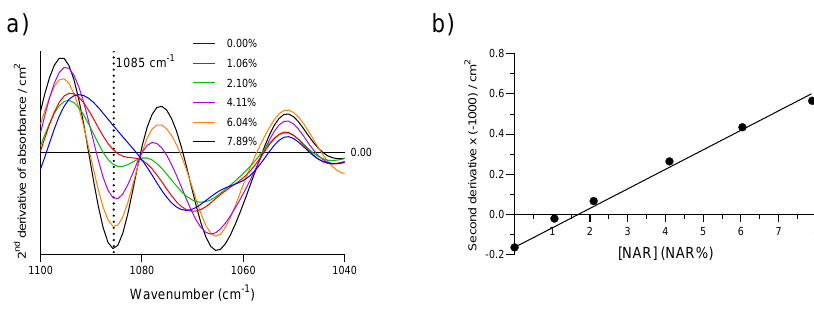
Figure 5. ( a ) The second derivative of the absorbance spectra of SFN with increasing quantities of NAR obtained at Stockholm University; ( b ) Calibration line constructed with the second derivative of the Absorbance spectra at 1085 cm − 1 multiplied by − 1. Each spectrum was smoothed with a thirteen-point Savitsky–Golay function before